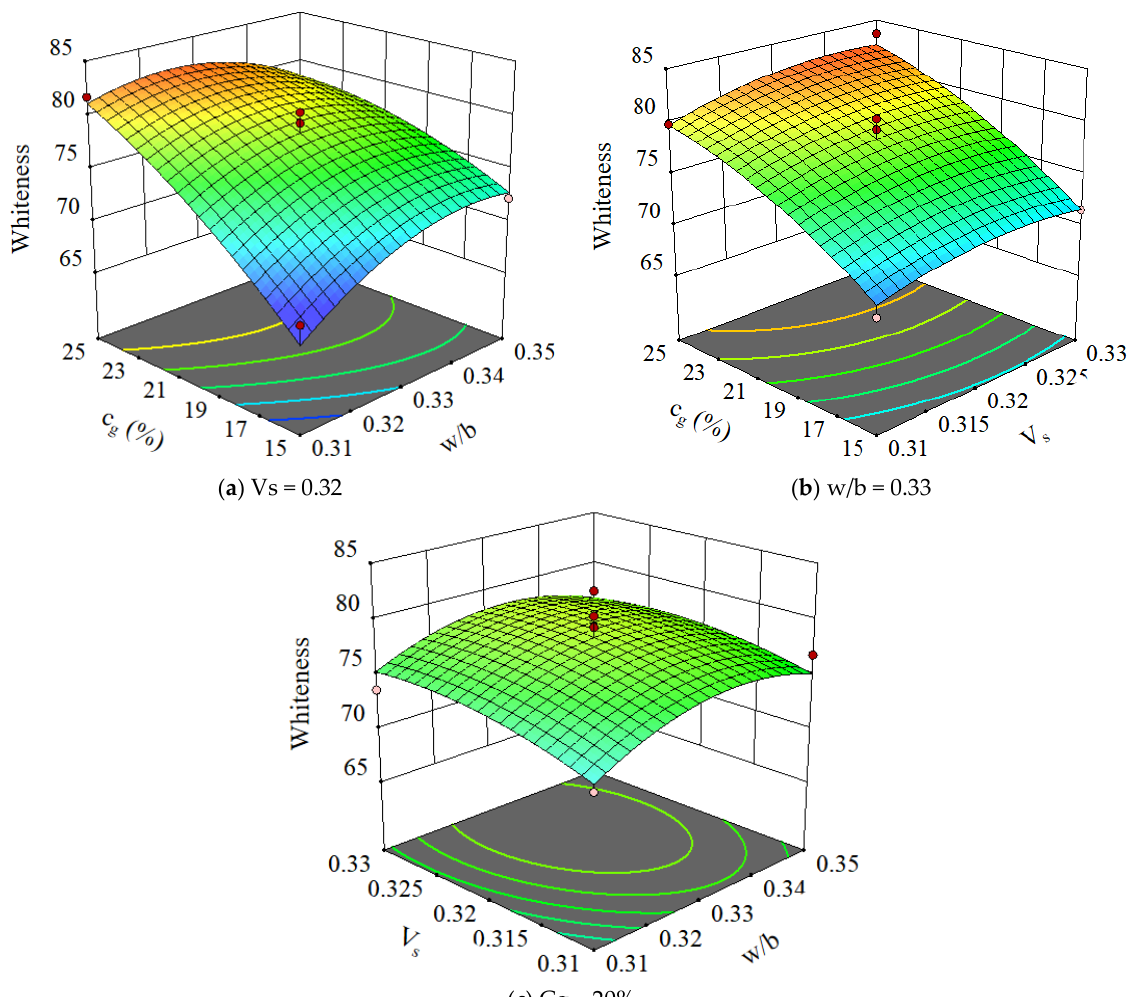
Figure 6. The 3D plots for whiteness of concrete.